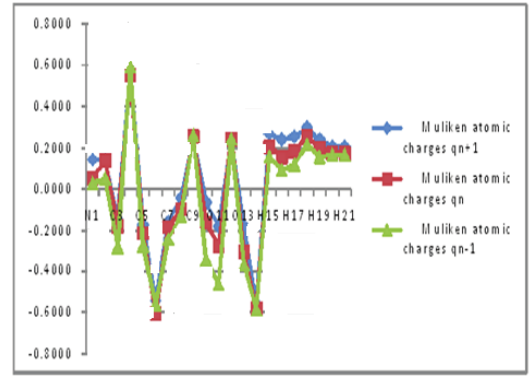
Figure 7 : Mulliken population analysis of N -acetylisatin.